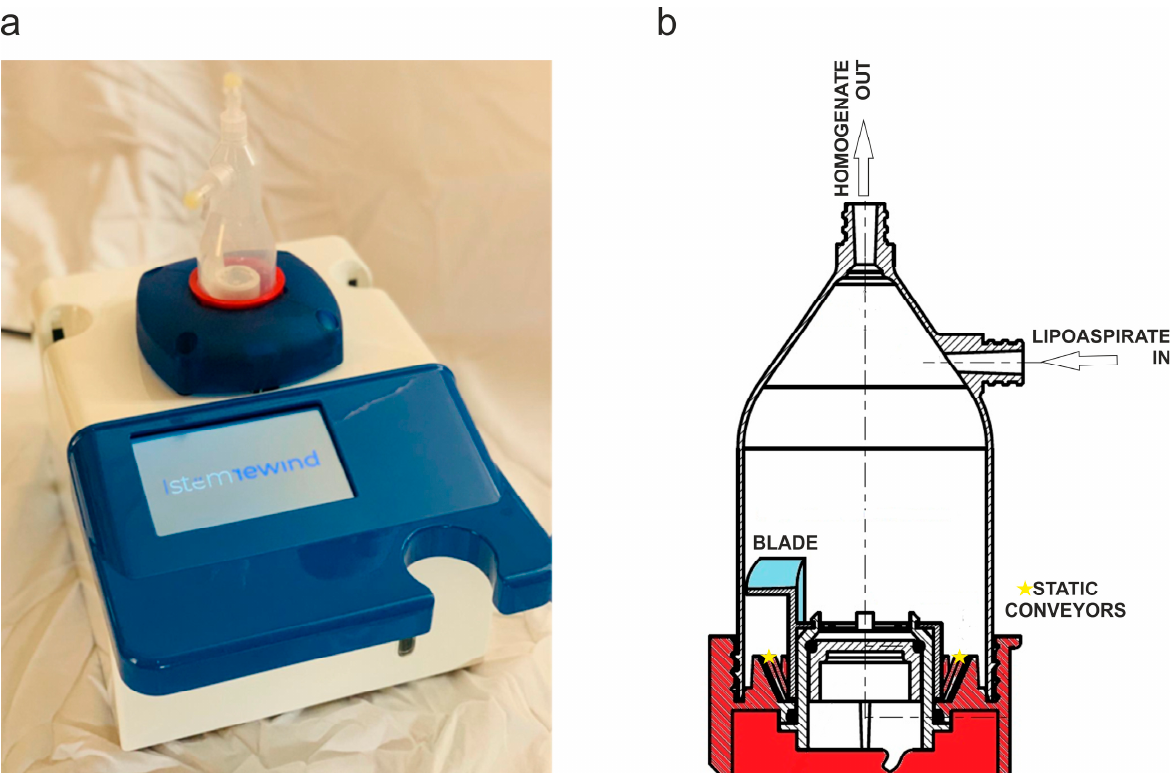
Figure 1. The IStemRewind device and the tube. ( a ) A picture of the IStemRewind system, a biological extractor equipped with a sterile disposable kit (IStemRewind tube). ( b ) A scheme of the IStemRewind tube structure: the entrance port of the biological sample (PORT A); the blade; the static conveyors and the door to extract the homogenate after the processing (PORT B) are